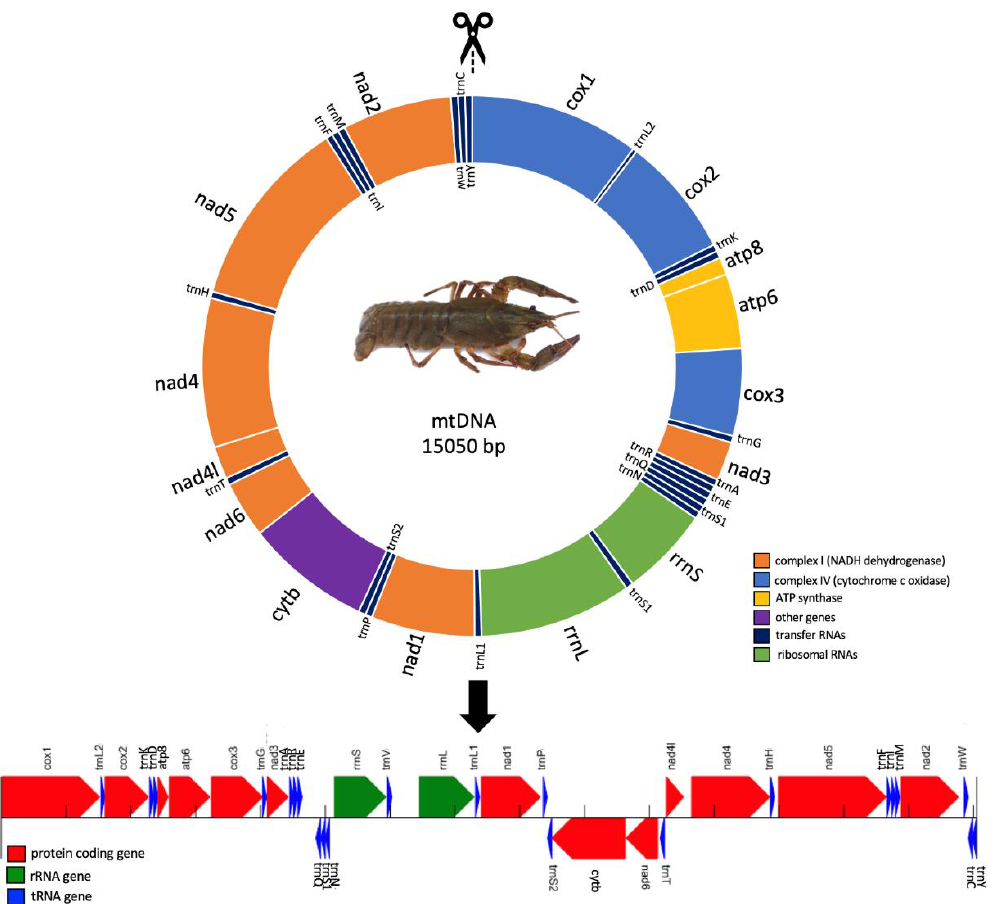
Figure 2. The annotated mitogenome of Pontastacus leptodactylus . Protein-coding, rRNA, and tRNA genes are shown with standard abbreviations and different colors. Arrows indicate transcription directions. The genes shown above the line indicate that the genes are on the direct strand, while genes depicted under the line are located on the reverse strand. Table 2. Annotation of the coding mitogenome of Pontastacus leptodactylus .